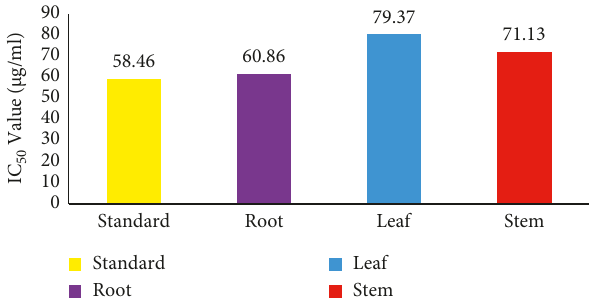
Figure 5: Anti-inflammatory assay of C. lanatum with IC